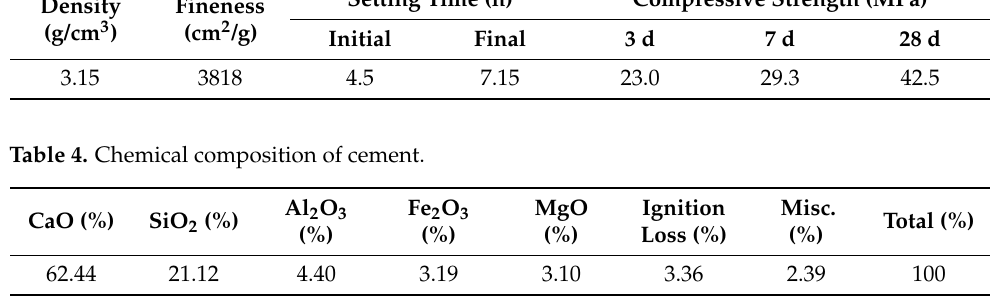
Table 3. Physical properties of cement.